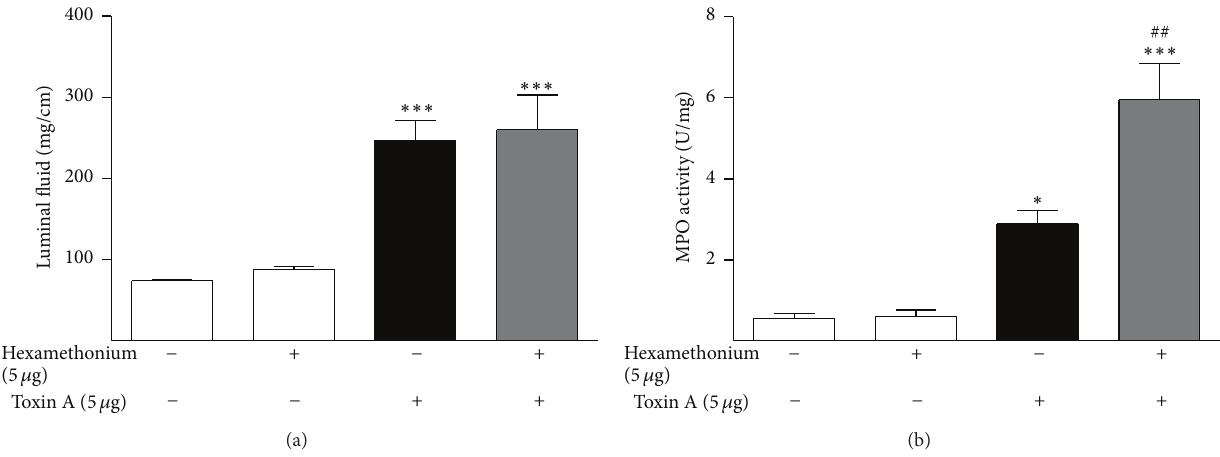
Figure 4: Effects of pretreatment with hexamethonium (5 𝜇 g) on toxin A-induced (5 𝜇 g) colonic luminal fluid accumulation (a) and MPO content (b). Administration of hexamethonium alone had no effect on colonic luminal fluid accumulation, MPO content, or toxin A- stimulated luminal fluid accumulation but significantly increased toxin A-stimulated MPO content. ∗ 𝑃 < 0.05 versus control; ∗∗∗ 𝑃 < 0.001 versus control; ## 𝑃 < 0.01 versus toxin A alone; 𝑁 = 6